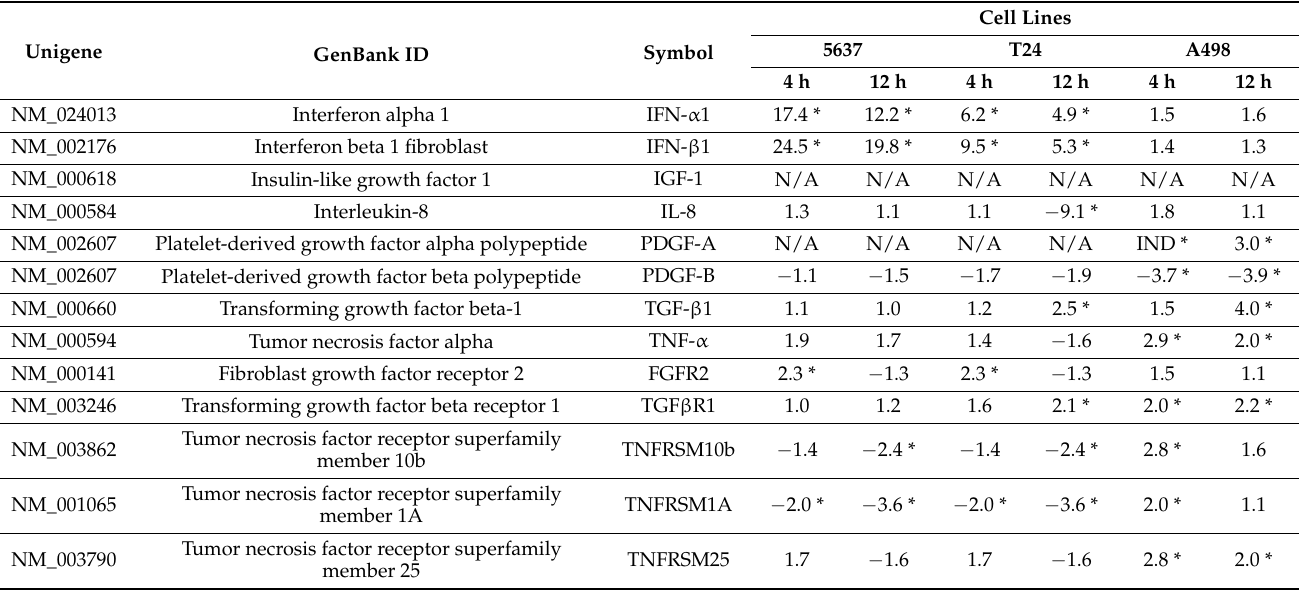
Table 2. Cytokines, growth factors and receptors’ gene expression in CPS (50 µ M)-treated 5637, T24 and A498